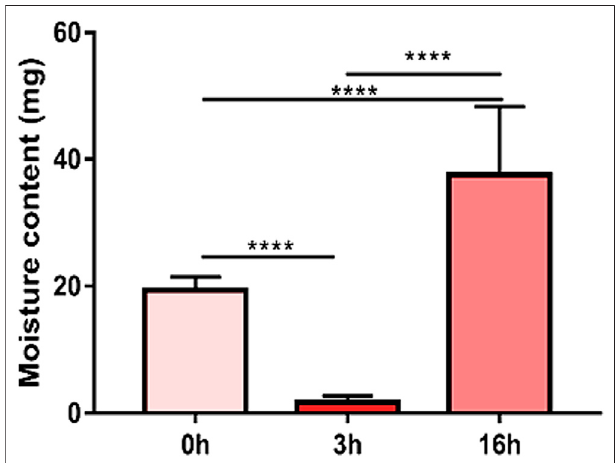
FIGURE 5 | Moisture content of the capsules ( n (cid:2) 5). There was a pronounced reduction in moisture content after drying the material at 50 ° C for 3 h ( **** means p <